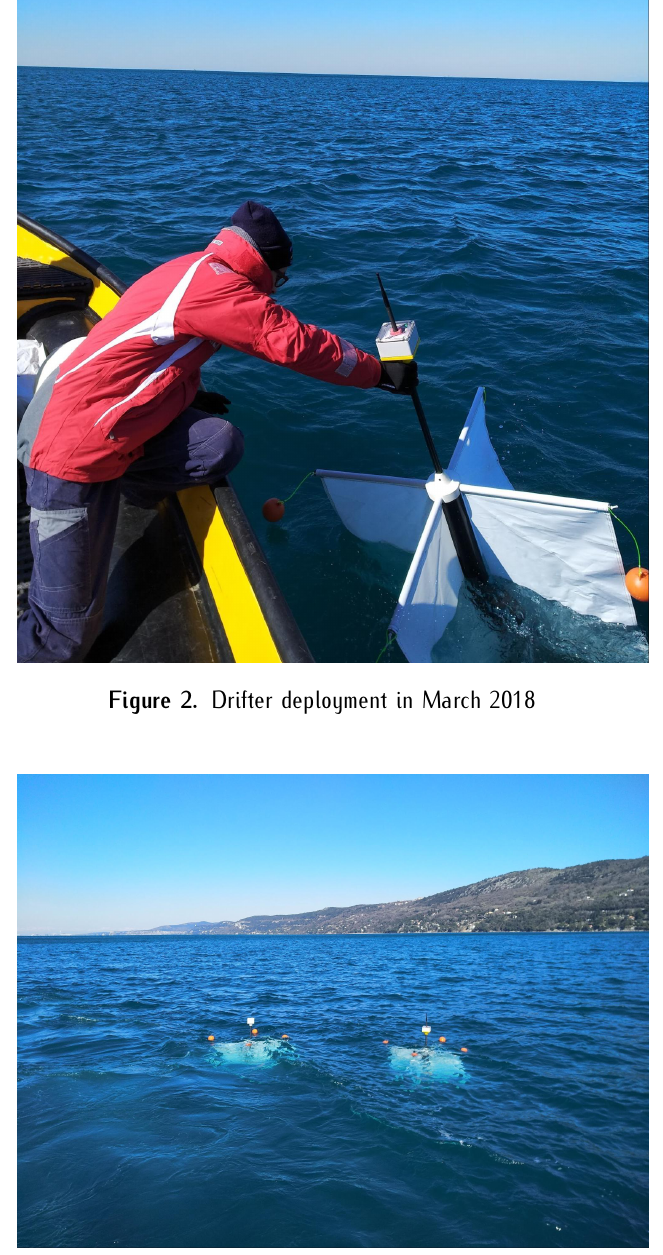
Indicator (RSSI) all around the Gulf of Trieste up to 10- 15 km away from the gateway, as displayed in Figure